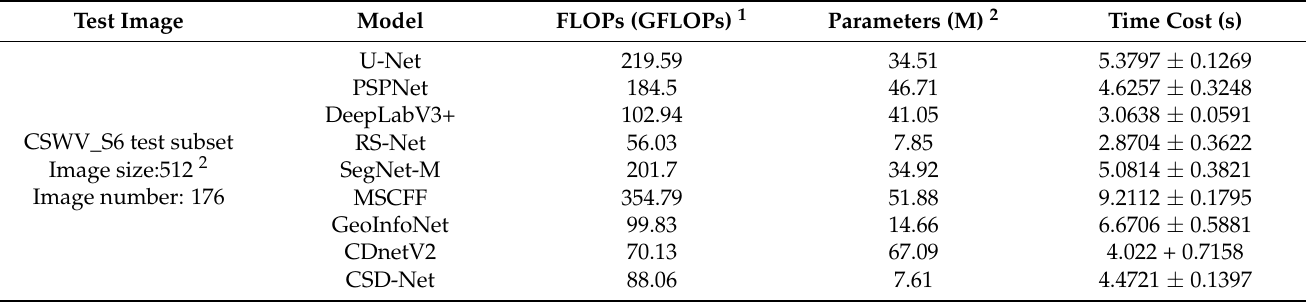
Table 5. The value of floating point operations, the number of parameters, and the time cost for several methods. Test Image